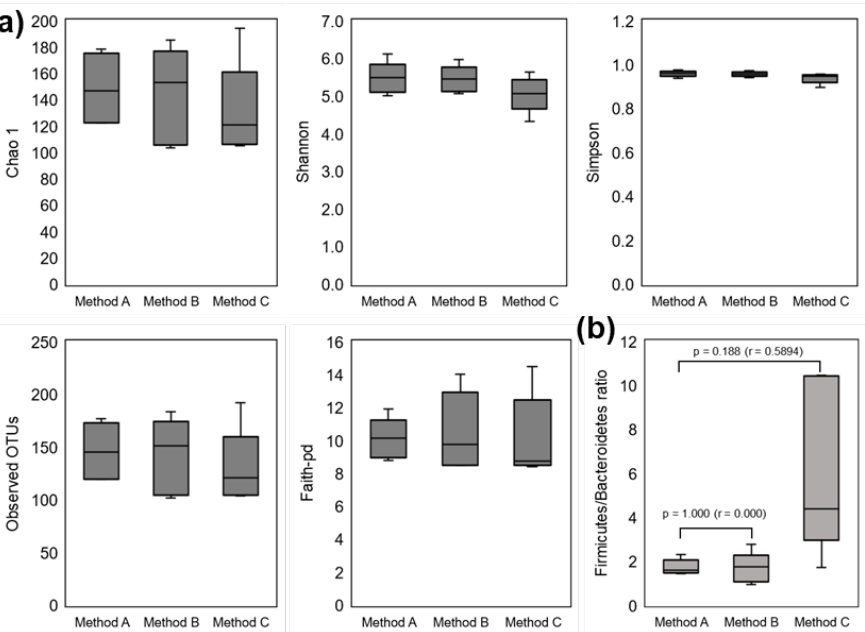
Figure 3. Research I : Diversity indices and the Firmicutes/Bacteroidetes ratio of the fecal bacterial community in five adult volunteers. ( a ) Diversity indices and the ( b ) Firmicutes/Bacteroidetes ratio in each method.